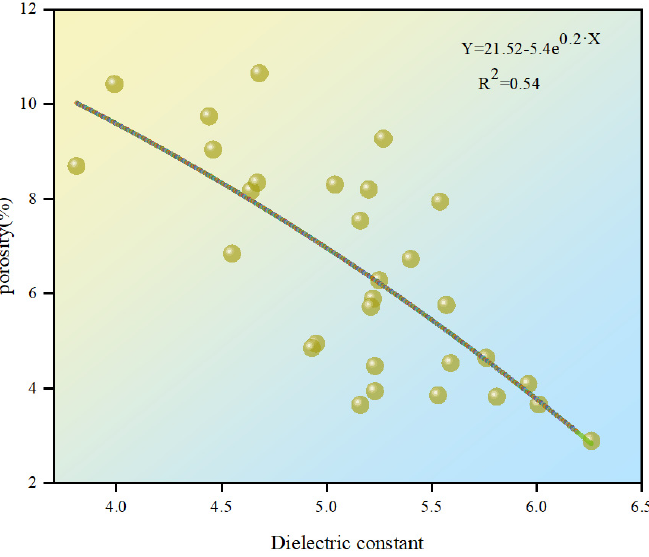
Figure 7. Fitting of the representative values of the dielectric constant obtained by Method 1 and the porosity.